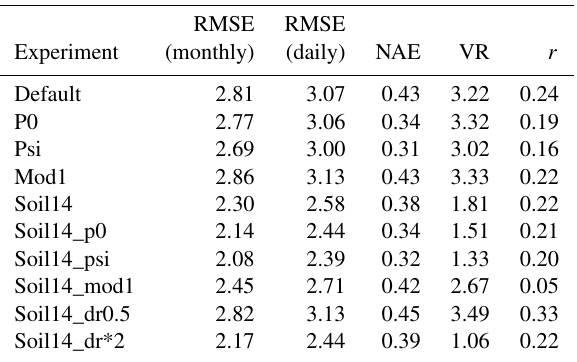
Table 7. Average results of soil moisture stress experiments for GPP at sites with soil moisture stress plus other errors (LBA-K67, LBA- BAN, RU-Che,